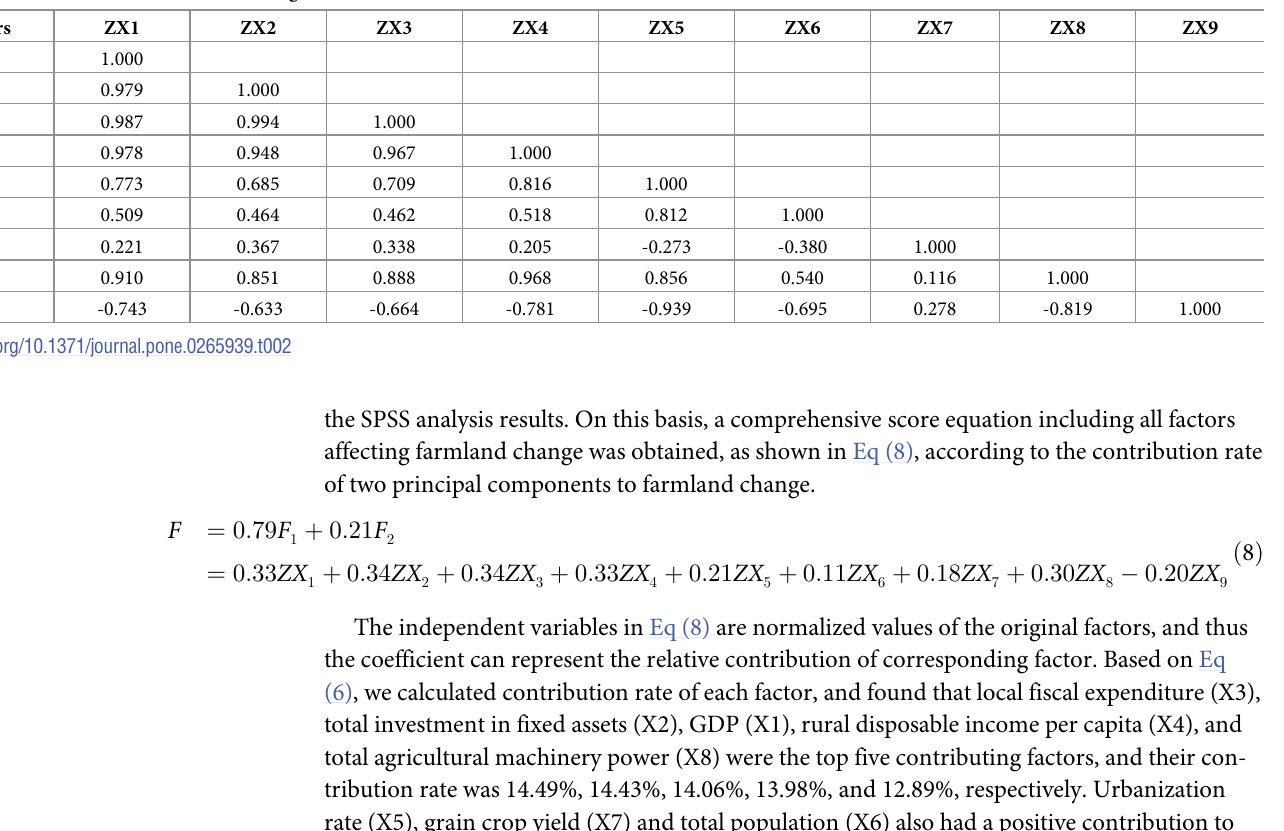
Table 2. Correlation coefficient matrix among the selected factors.